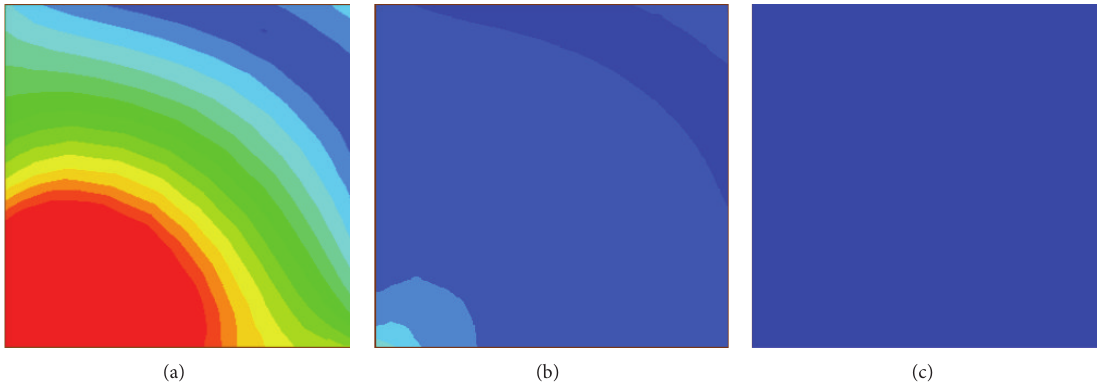
Figure 9: Electric field intensity distribution in the package cavity versus different radii of the grounded vias with the number of vias of 56, (a) 0.2 mm, (b) 0.4 mm, and (c) 0.6